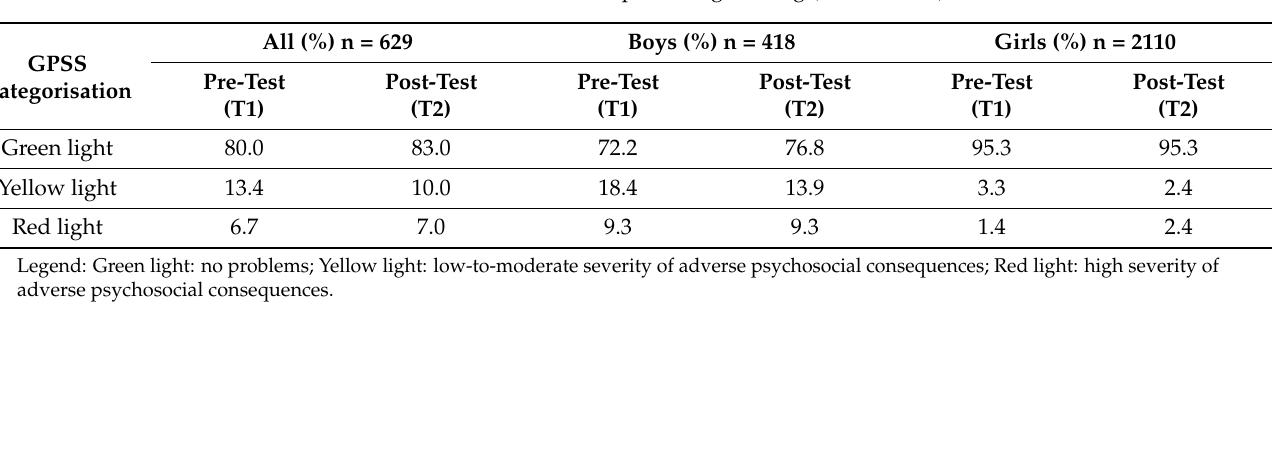
Table A2. Prevalence of students’ problem gambling